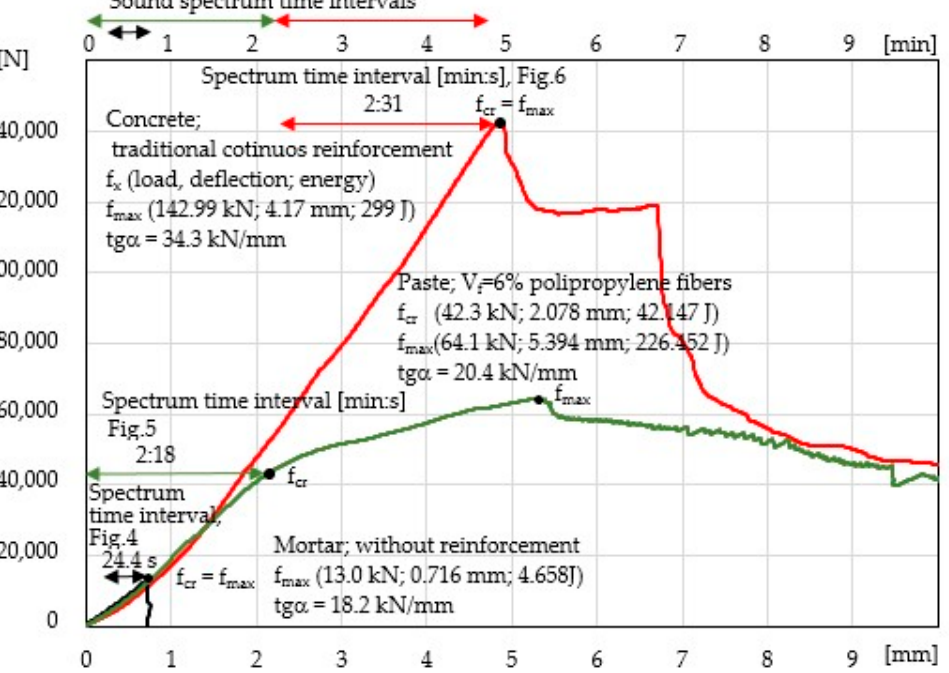
Figure 3. Load–deflection curves of the specimens during the bending test with the analysed sound spectrum time